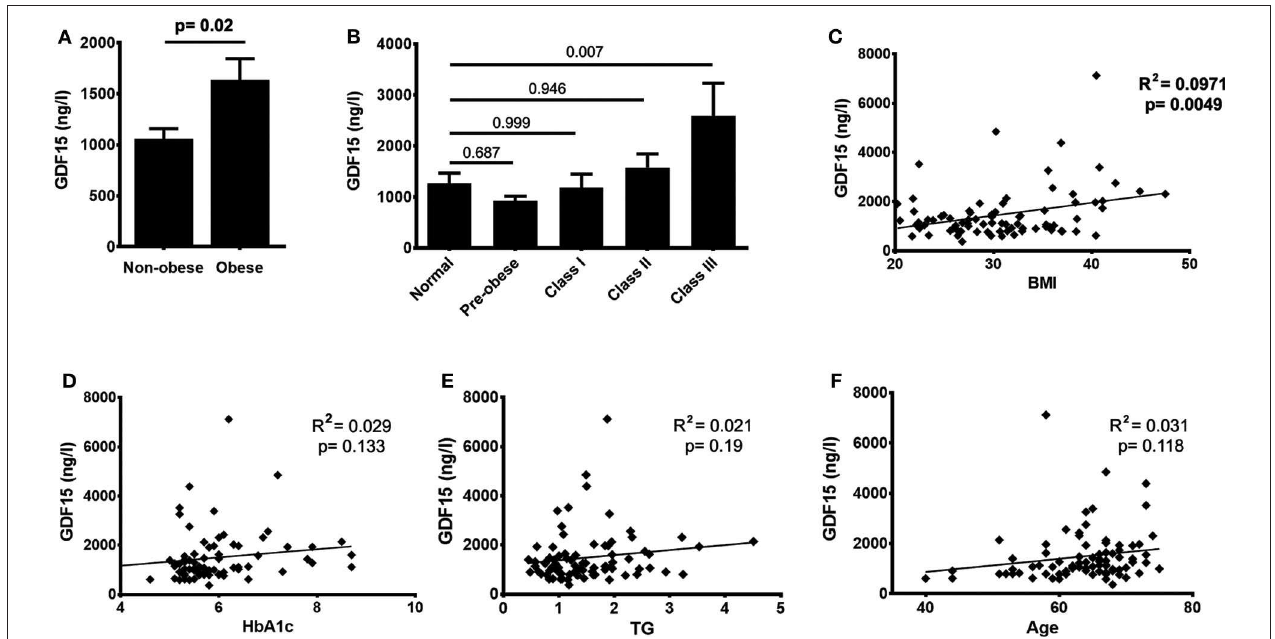
FIGURE 1 | GDF15 significantly correlates with obesity but not with metabolic status of patients. (A) Levels of GDF15 in the plasma are increased in obese patients compared to non-obese patients. (B) GDF15 increased in obesity classes II and III, with a significant difference between normal and class III patients. (C) Circulating GDF15 also significantly correlates with body mass index (BMI), but not with glycated hemoglobin (HbA1c), triglycerides or age (D–F) . Data were analyzed using unpaired t -test, one-way ANOVA, Pearson’s correlation and regression.